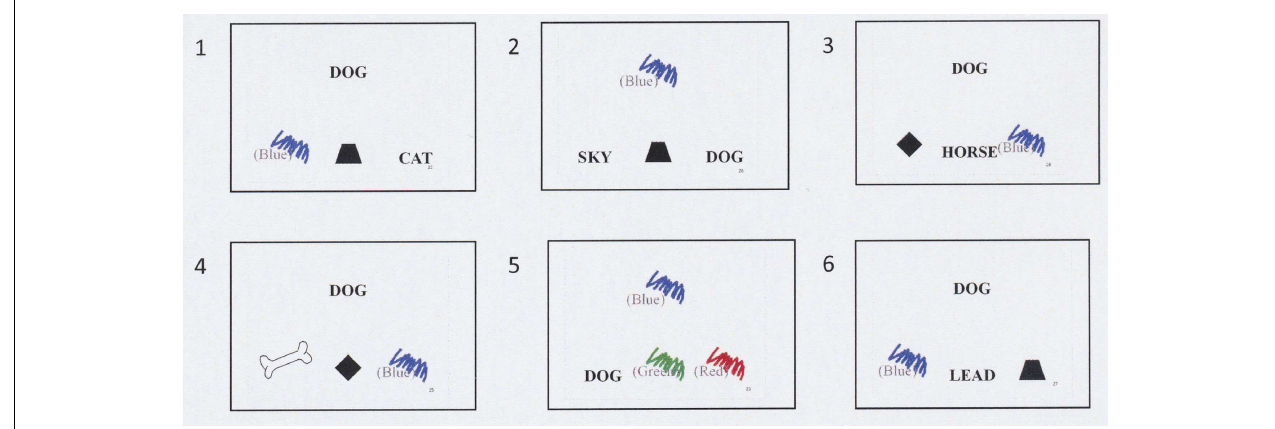
FIGURE 2 |The six test trial used to test distraction